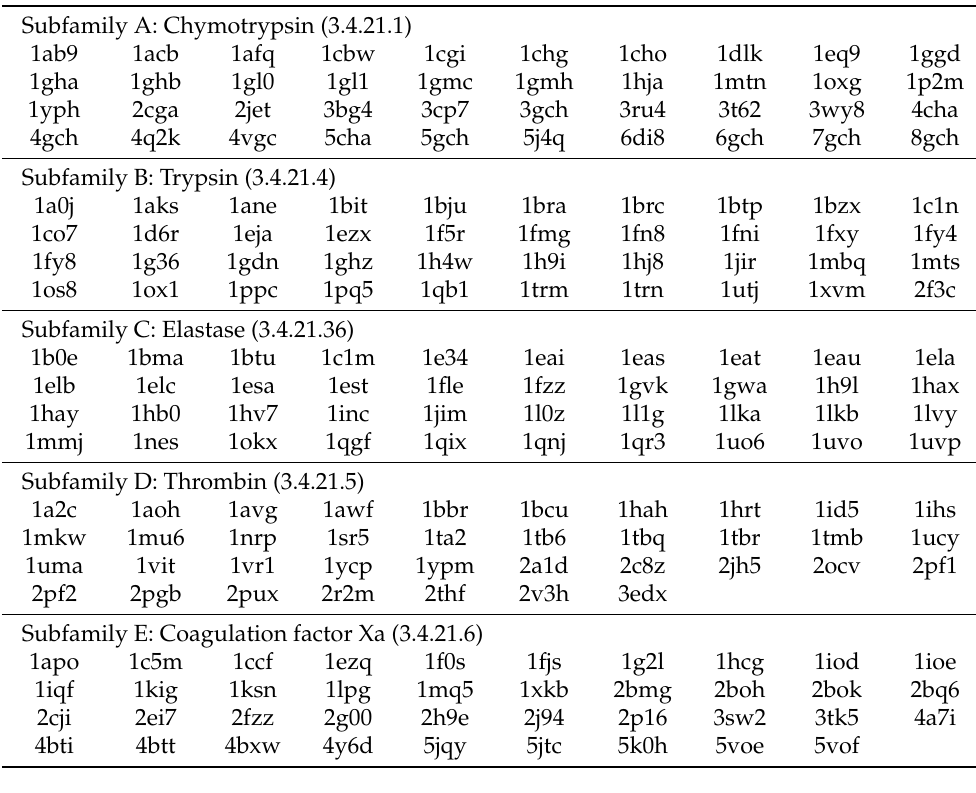
Table A2. Dataset: Primary-2.